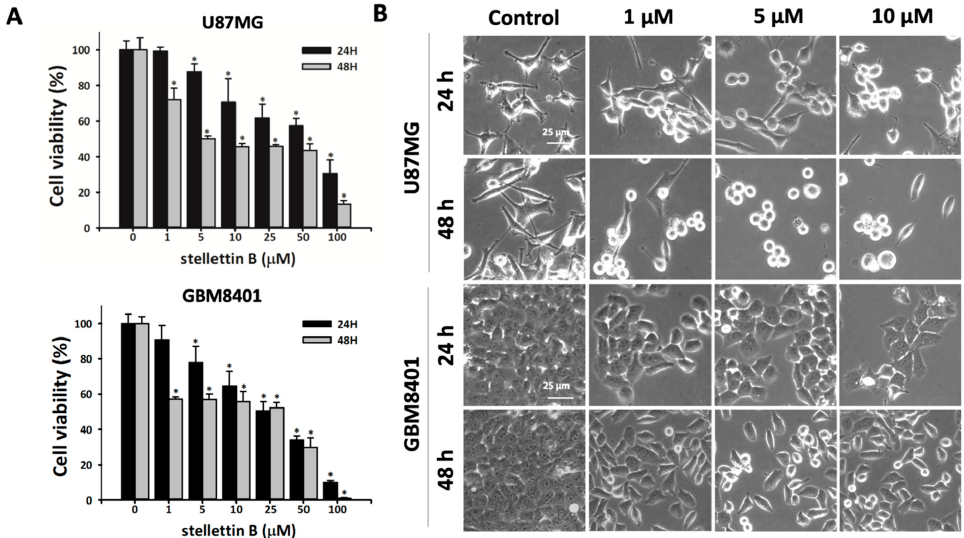
Figure 1. Stellettin B affects the viability of glioblastoma cell lines. ( A ) U87MG and GBM8401 cells were treated with 0, 1, 5, 10, 25, 50, or 100 µ M stellettin B for 24 or 48 h. Cell viability was determined using 3-(4,5-dimethylthiazol-2-yl)-2,5-diphenyl tetrazolium bromide (MTT) assay. Data are presented as mean ± standard deviation (SD) ( n = 3). * p < 0.05 relative to controls. ( B ) Morphology of U87MG and GBM8401 cells after treatment with 0, 1, 5, or 10 µ M stellettin B for 24 or 48 h. Cells were observed using phase-contrast microscopy. Scale bars, 25 μ m.